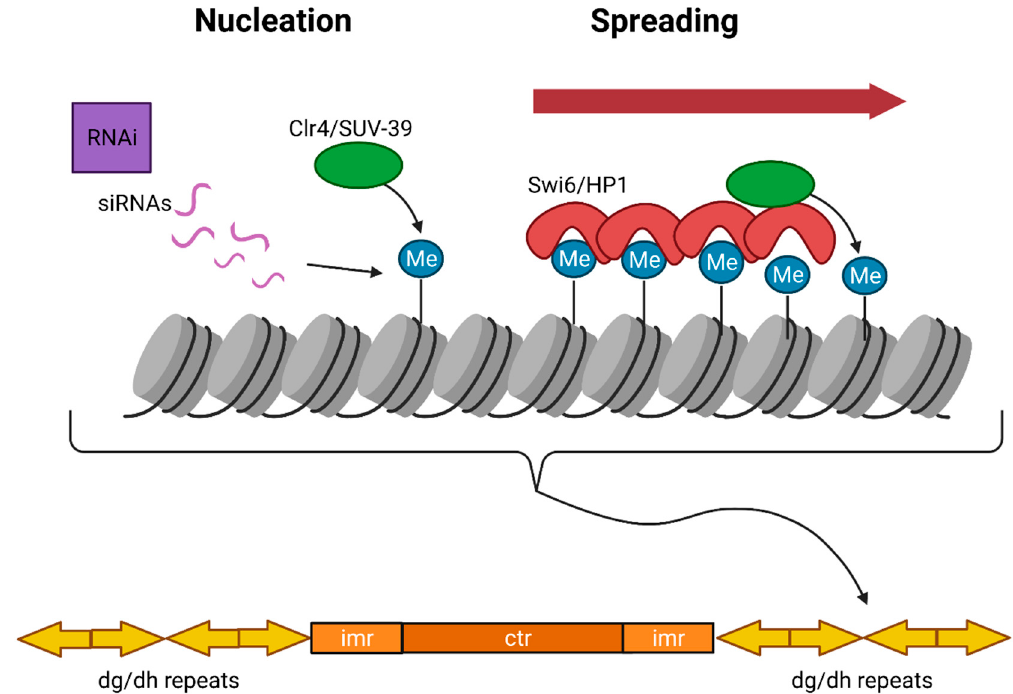
Figure 3. Establishment and spreading of constitutive heterochromatin in S. pombe. In S. pombe , H3K9me3 is established by the RNAi pathway in which siRNAs facilitate the recruitment of Clr4 H3K9me3 HMT. H3K9me3 is recognized by Swi6, which then recruits Clr4 to adjacent repeats leading to the spreading of constitutive heterochromatin until the process is stopped by boundary elements (not shown).